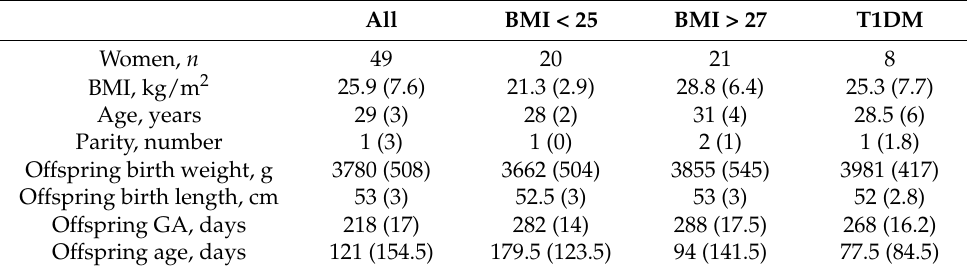
Table 1. Demographic characteristics of the women and their offspring.